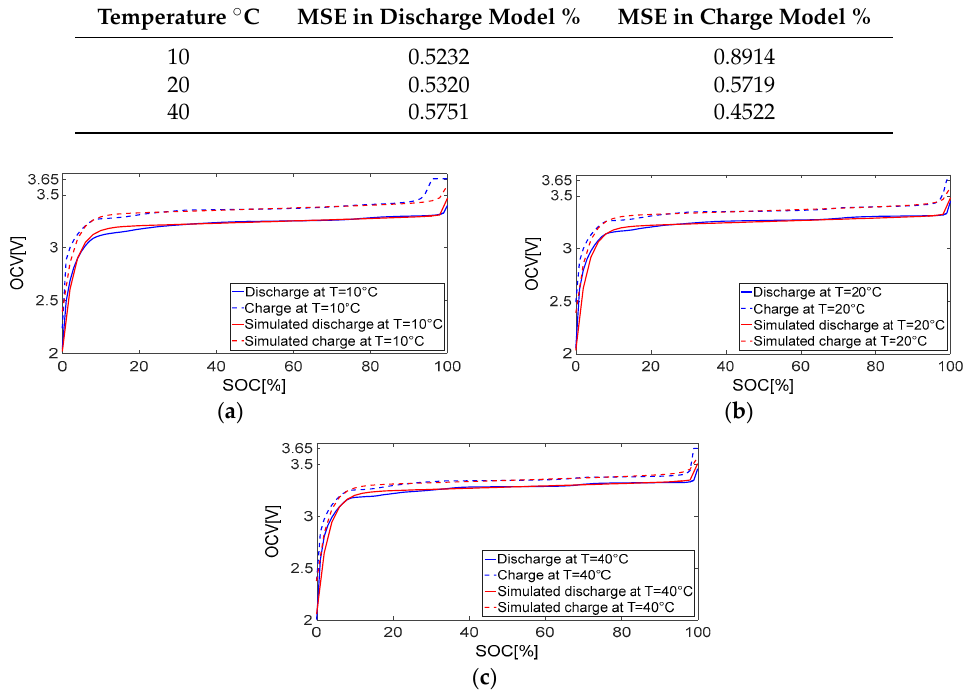
Figure 8. The new V oc model and measured experimental data: ( a ) T = 10 °C; ( b ) T = 20 °C; ( c ) T = 40 °C.